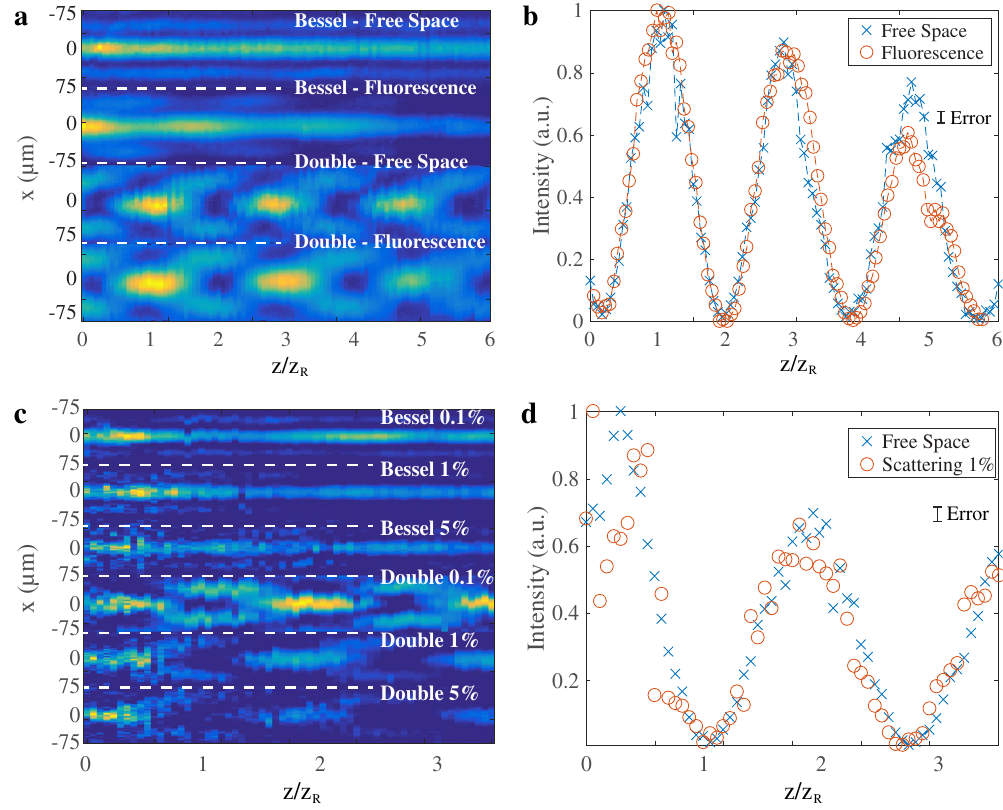
Figure 4. Top view ( a ) and axial intensity profile ( b ) of the fluorescent signal given by the light droplet illumination. A thin glass layer labeled with Rhod-2 fluorescent molecules was used as a sample. To maintain a constant magnification, the glass layer was translated along the ˆ z direction together with the imaging system. As expected, the fluorescent signal reproduces the illumination profile. Top view ( c ) and axial intensity profile ( d ) of light droplets in water-milk solutions at different concentrations. The beams are shown to form droplets also in the presence of absorption and